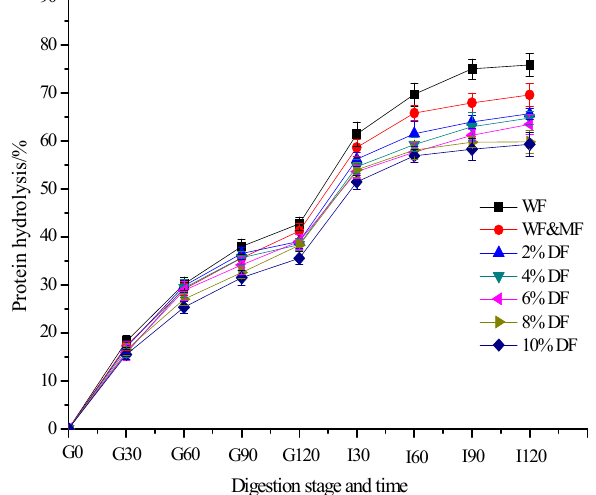
Figure 2. Effects of various samples on protein digestibility in vitro. G0, G30, G60, G90, and G120 represent the protein hydrolysis times of 0, 30, 60, 90, and 120 min, respectively, during gastric phase; I30, I60, I90 and I120 represent the protein hydrolysis times of 0, 30, 60, 90, and 120 min, respectively, during intestinal phase.